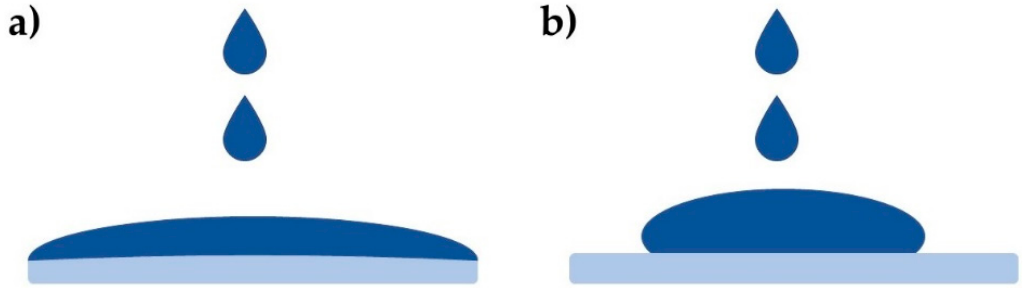
Figure 7. Schematic depicting the way PEDOT:PSS spreads onto ( a ) a UV-O 3 treated glass-ITO substrate and ( b ) a non-UV-O 3 treated glass ITO substrate. The UV-O 3 treatment increases the hydrophilicity if the ITO surface thus ensuring that the aqueous PEDOT:PSS solution spreads more evenly on the entire area.